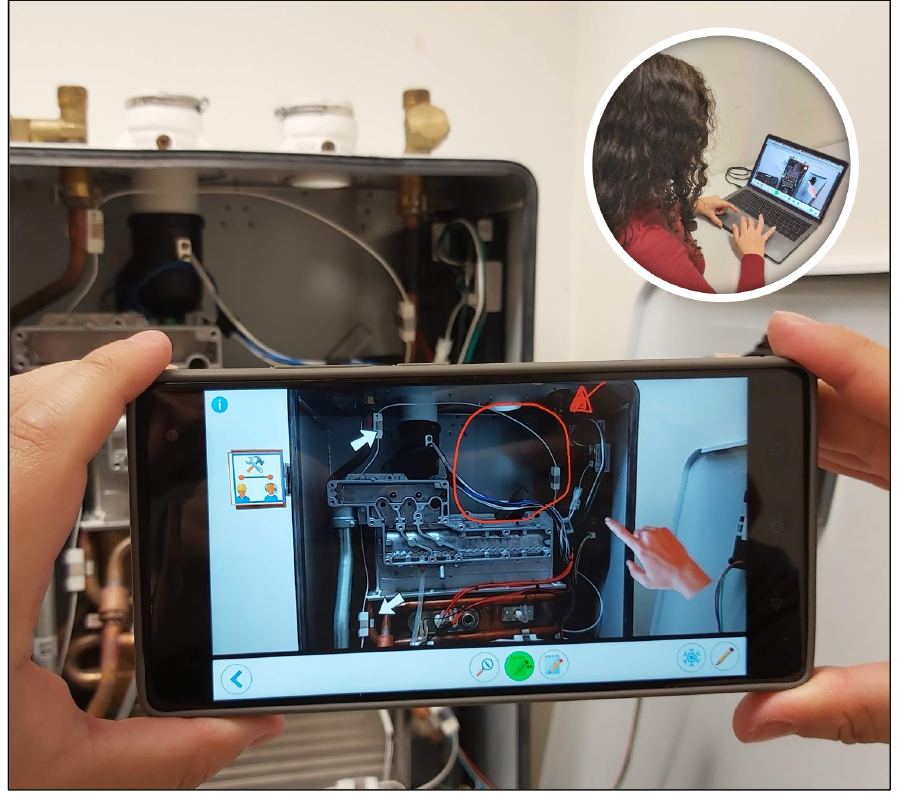
Figure 3. On-site collaborator performing an augmentation of the instructions suggesting where a new component should be installed (provided by the remote expert) on top of the real